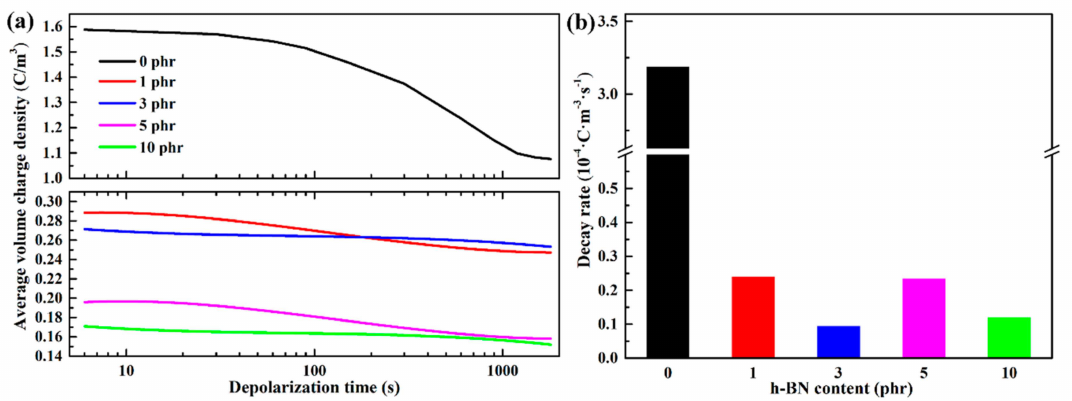
Figure 8. ( a ) The average volume charge density and ( b ) decay rate of the LDPE and h-BN / LDPE composites during depolarization after poling at 40 kV /